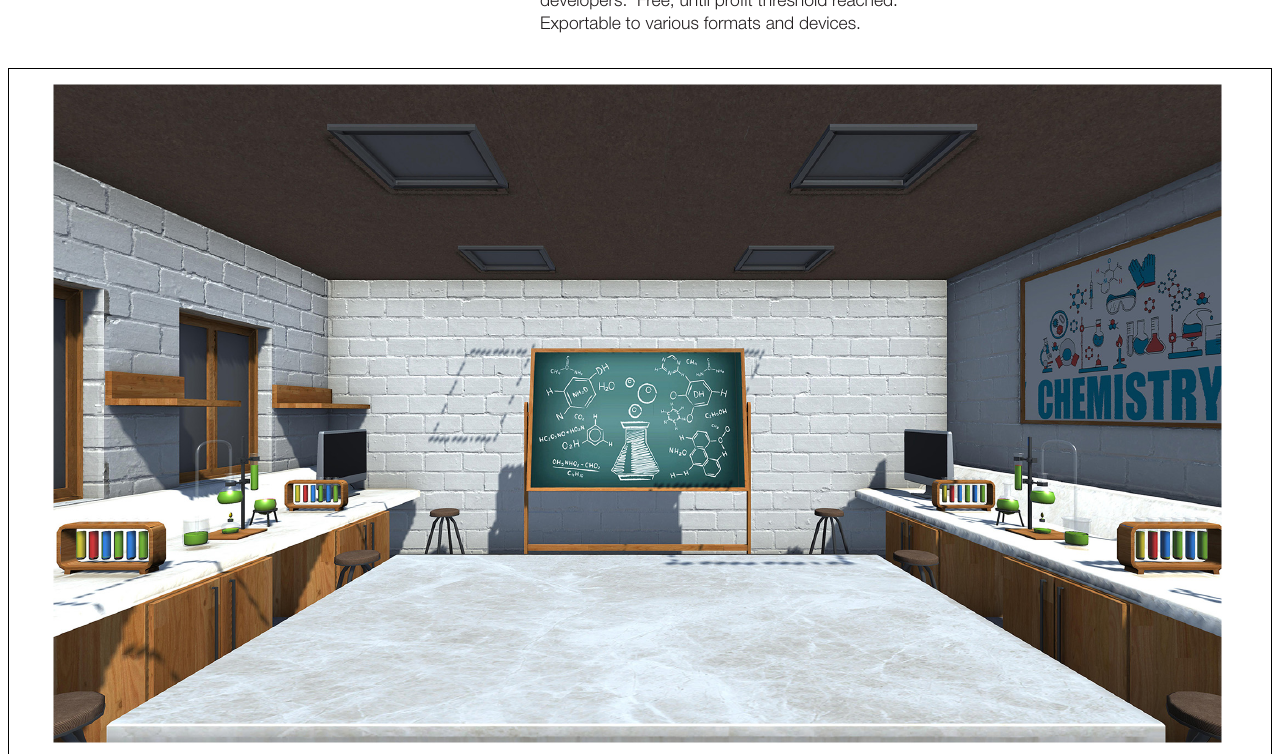
FIGURE 1 | 3D model of a chemistry laboratory used in our